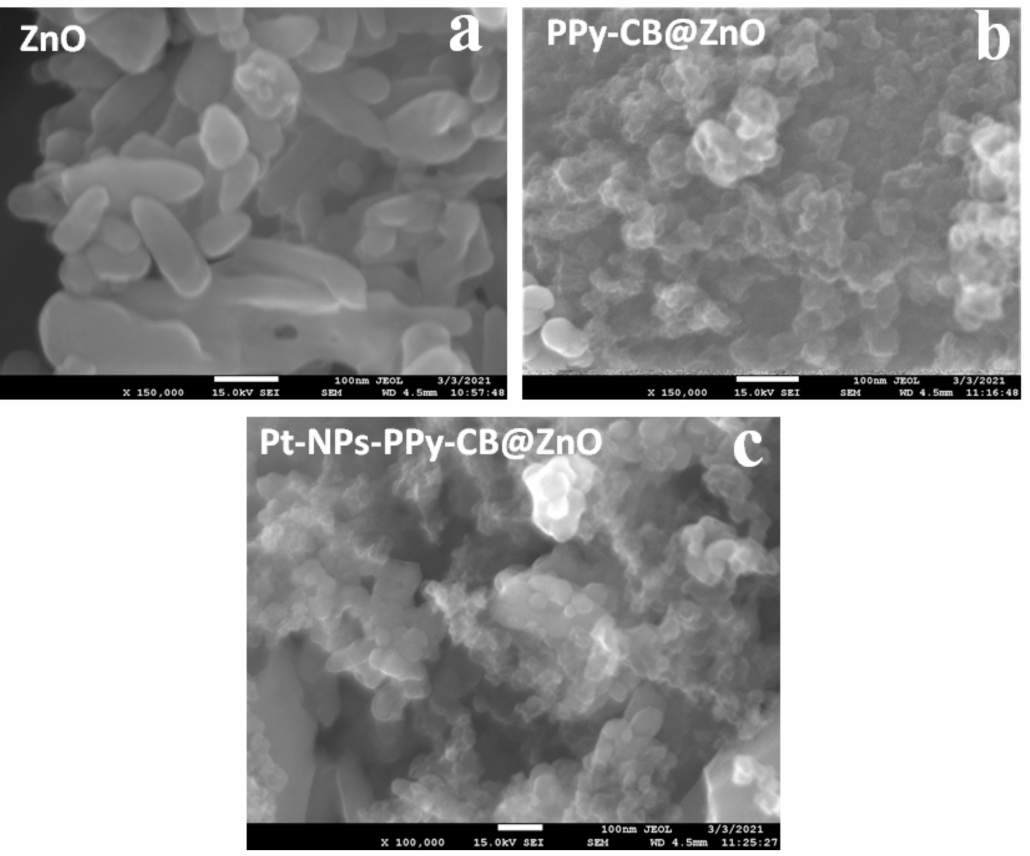
Figure 1. The FESEM analysis of Pt NPs-embedded PPy-CB@ZnO NCs explored ( a ) the capsule-like structure of ZnO, ( b ) the image of PPy-CB@ZnO, and ( c ) the nanocomposite structure of prepared Pt NPs-embedded PPy-CB@ZnO.